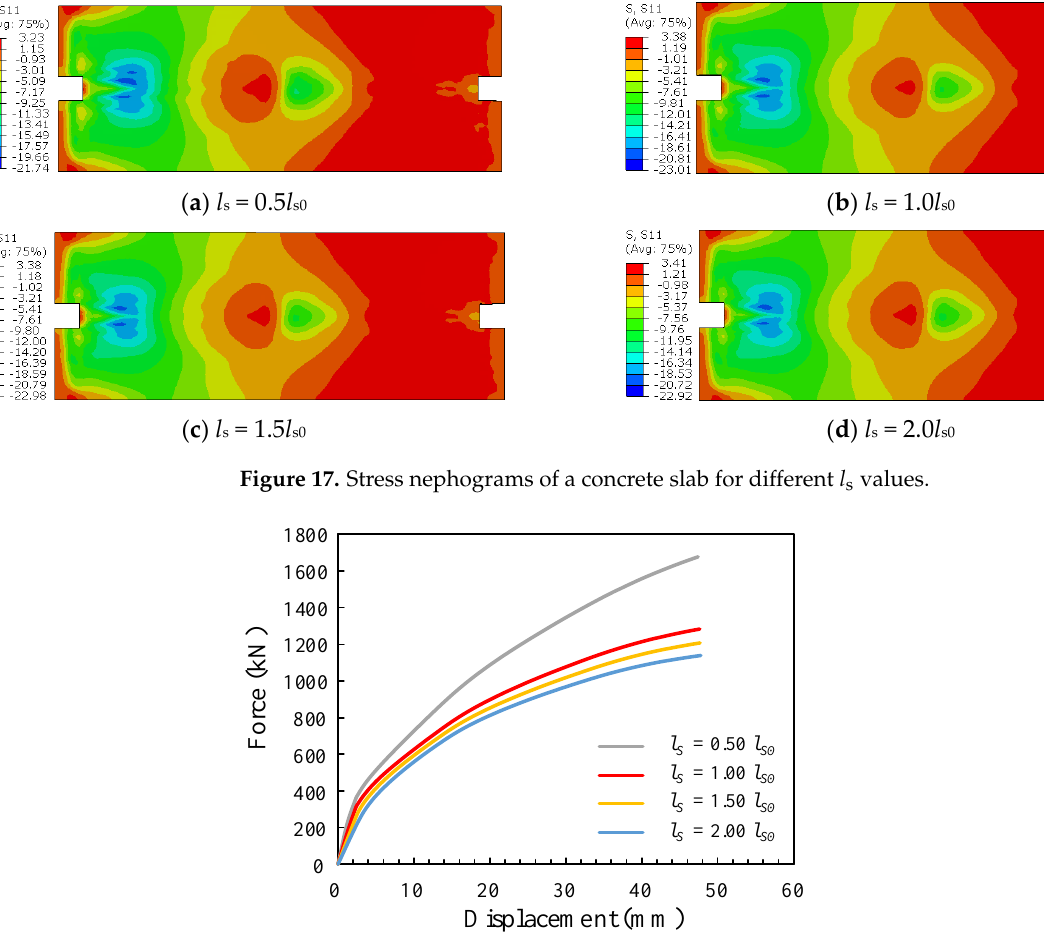
Figure 18. Load–displacement curves for different l s Figure 18. Load – displacement curves for different l s values.